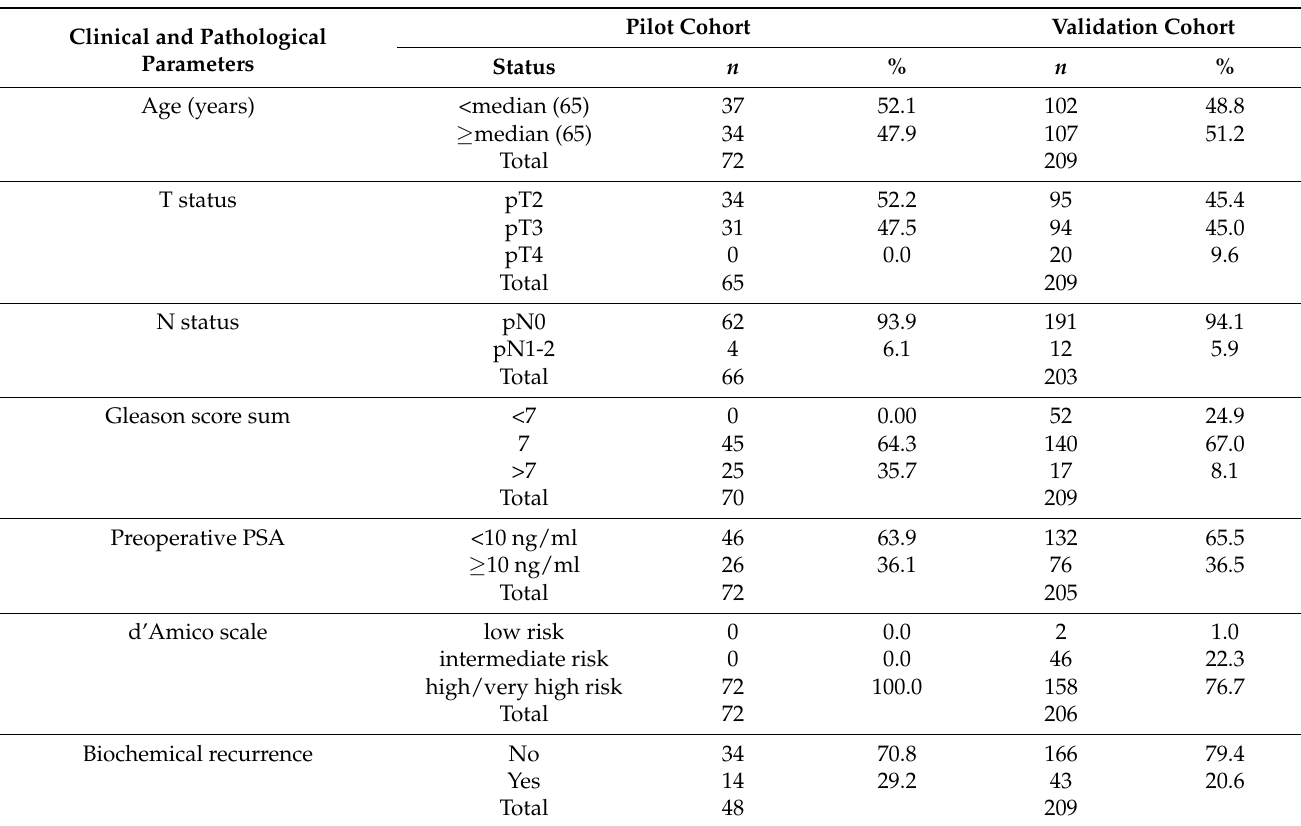
Table 1. Distribution of clinical parameters in the pilot and validation cohort of eligible patients. PSA, prostate-specific antigen. Note that not all numbers sum up to 72 and 209 due to the missing